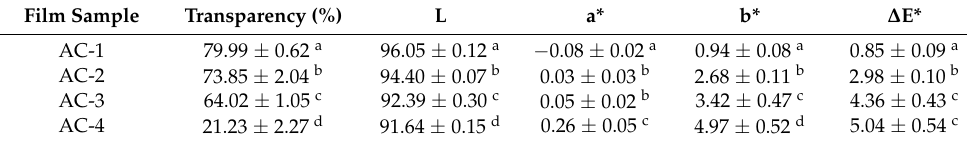
Table 2. Transparency and color parameters of SA–AG hydrogel-based